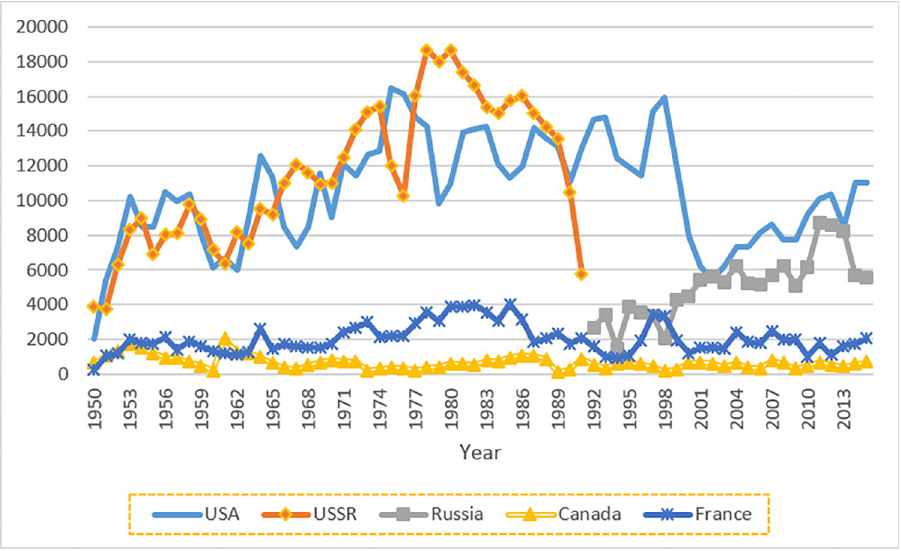
Fig 4. Total arms sale value by year of states with a high degree of betweenness centrality in the 2000 political alliance network, 1950–2015. The value includes exports from each state as well as imports to the state. Unit: US